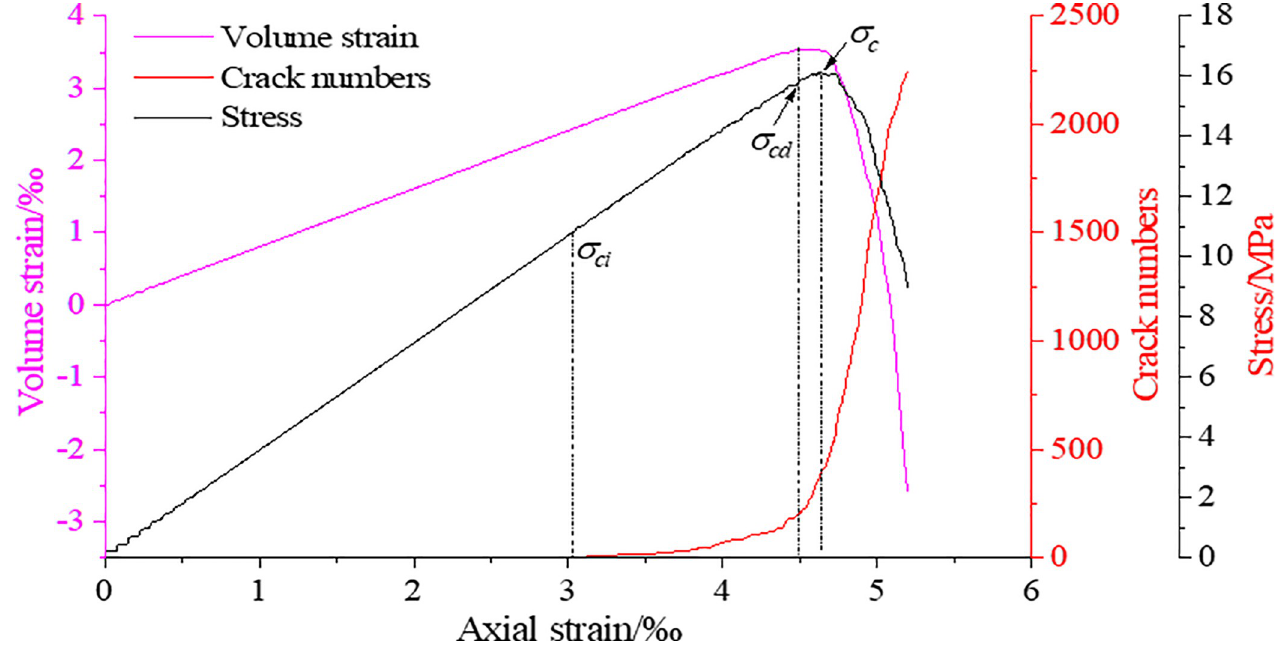
Fig 7. Calibration of crack initiation stress and dilatation stress of coal and rocks.